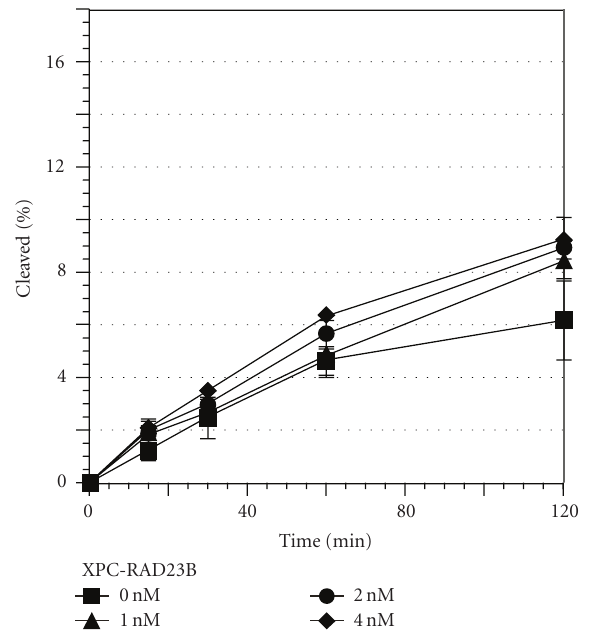
Figure 4: The e ff ect of XPC on the activity of Ec MUG that cleaves uracil from G/U mismatches. The activity of Ec MUG was measured by using 1.6 nM of 60-bp DNA containing a single G/U mismatch as a substrate. The reaction was done at 30 ◦ C for the specified time with 0.8nM His- Ec MUG and indicated concentrations of XPC- RAD23B. The DNA samples were then purified and subjected to alkali-treatment to cleave the resulting AP sites and separated with denaturing PAGE. The ratio of the cleaved product was calculated and plotted as a graph. The mean values and standard errors were calculated from at least two independent